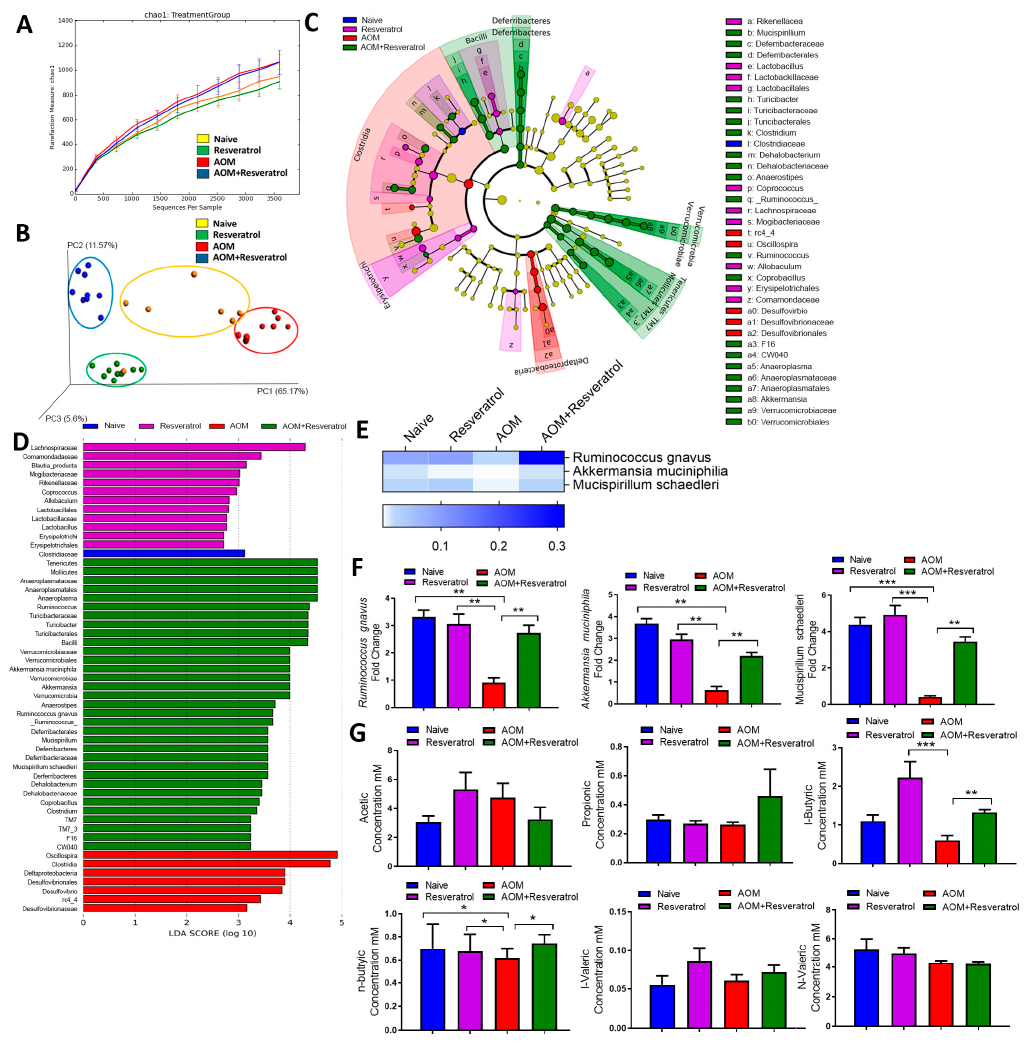
Figure 2. 16S rRNA sequencing analysis during AOM-induced CRC treated with resveratrol. The study wasdesignedasdescribedinFigure1legend.